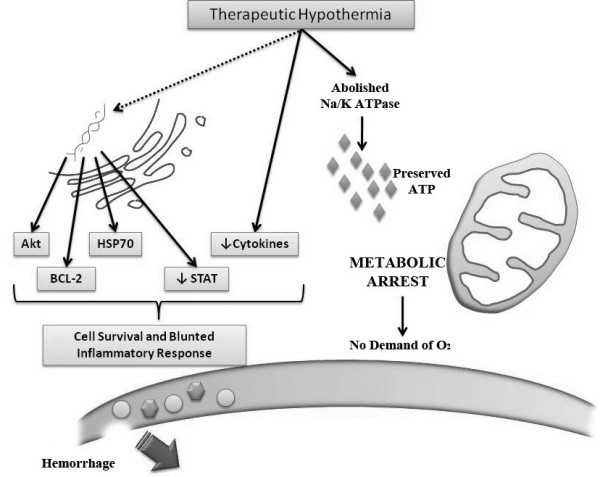
The molecular changes associated with induced therapeutic hypothermia. Minimal metabolic activity due to inactivation of Na+/K+ ATPase pump conserves ATP in the cell and abolishes the need for oxygen and substrates during the circulatory arrest. Induced hypothermia also affects several molecular pathways altering the expression of many intermediates and leads to decreased inflammation, decreased neutrophils migration and decrease apoptosis. Production of ROS is blunted as well. TNFR = Tumor Necrosis Factor Receptor. Cyt-C = Cytochrome C. ROS = Reactive Oxygen Species. STAT = Signal Transducers and Activators of Transcription. HSP 70 = Heat Shock Protein. JNK = stress-activated protein c-jun Kinase.